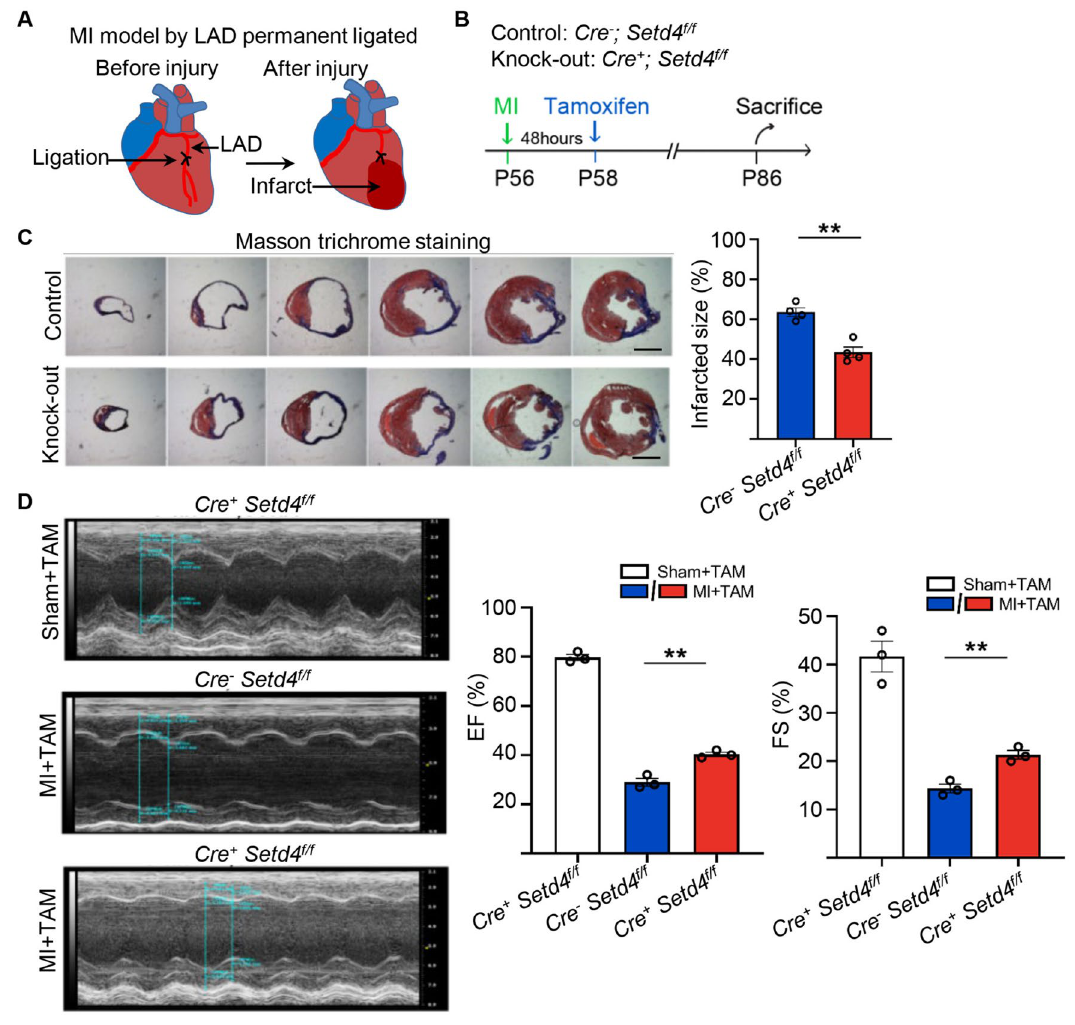
Figure 6. Knock-out of Setd4 improves cardiac function in MI-injured mice. ( A ) Diagram of MI-induced injury. ( B ) Experimental outline for injured hearts of c-Kit-CreER T2 (Cre + ) ; Setd4 f/f and c-Kit- CreER T2− (Cre - ) ; Setd4 f /f mice. ( C ) Masson trichrome staining and quantification for infarction size in hearts of Setd4 knock-out and control mice. Scale bars = 2 mm. n = 4 mice. ( D ) Detection of left ventricular function by transthoracic 2-dimensional echocardiography of Setd4 knock-out and control mice. n = 3 mice. All data are represented as mean ± SEM. Unpaired t test for ( C ), two-way ANOVA with Bonferroi’s correction for multiple comparisons test for ( D ). ** p <